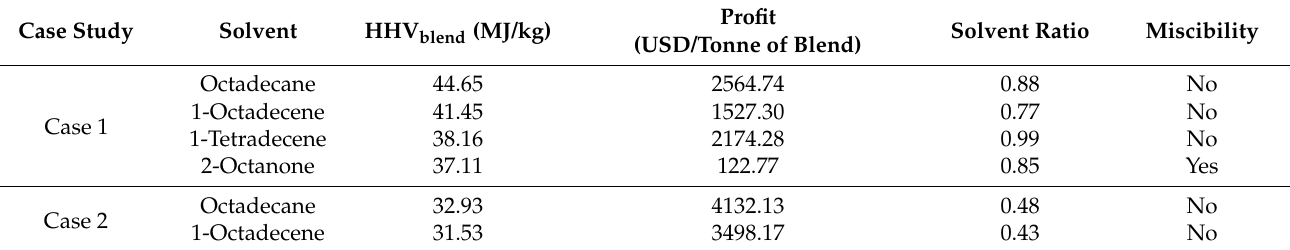
Table 7. Results for solvent blend